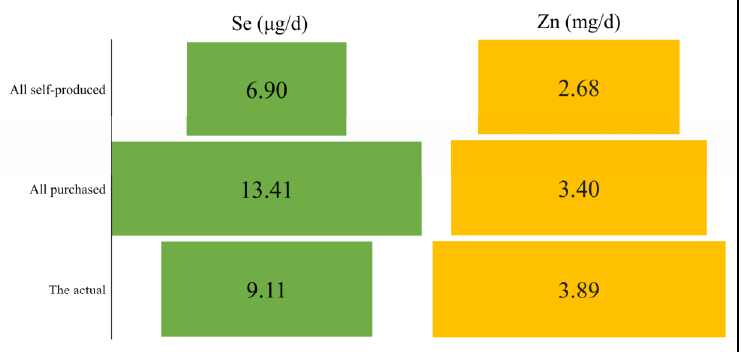
Figure 6. Se and Zn intakes of three assumptions.